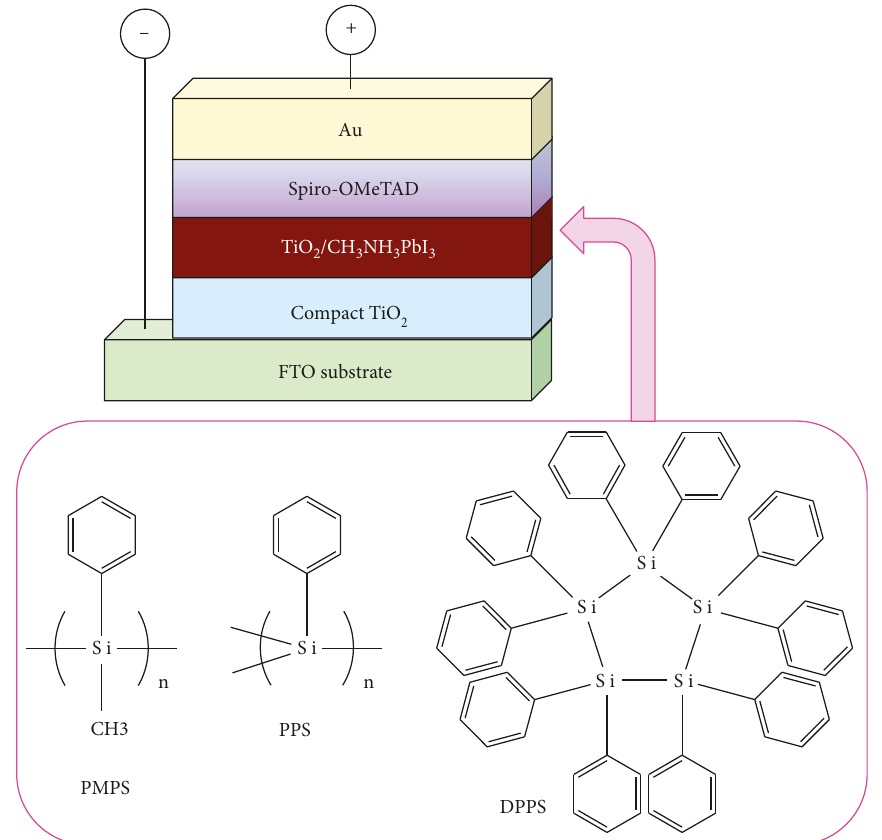
Figure 1: Schematic illustration of the present photovoltaic cells and structure models of the present polysilanes.